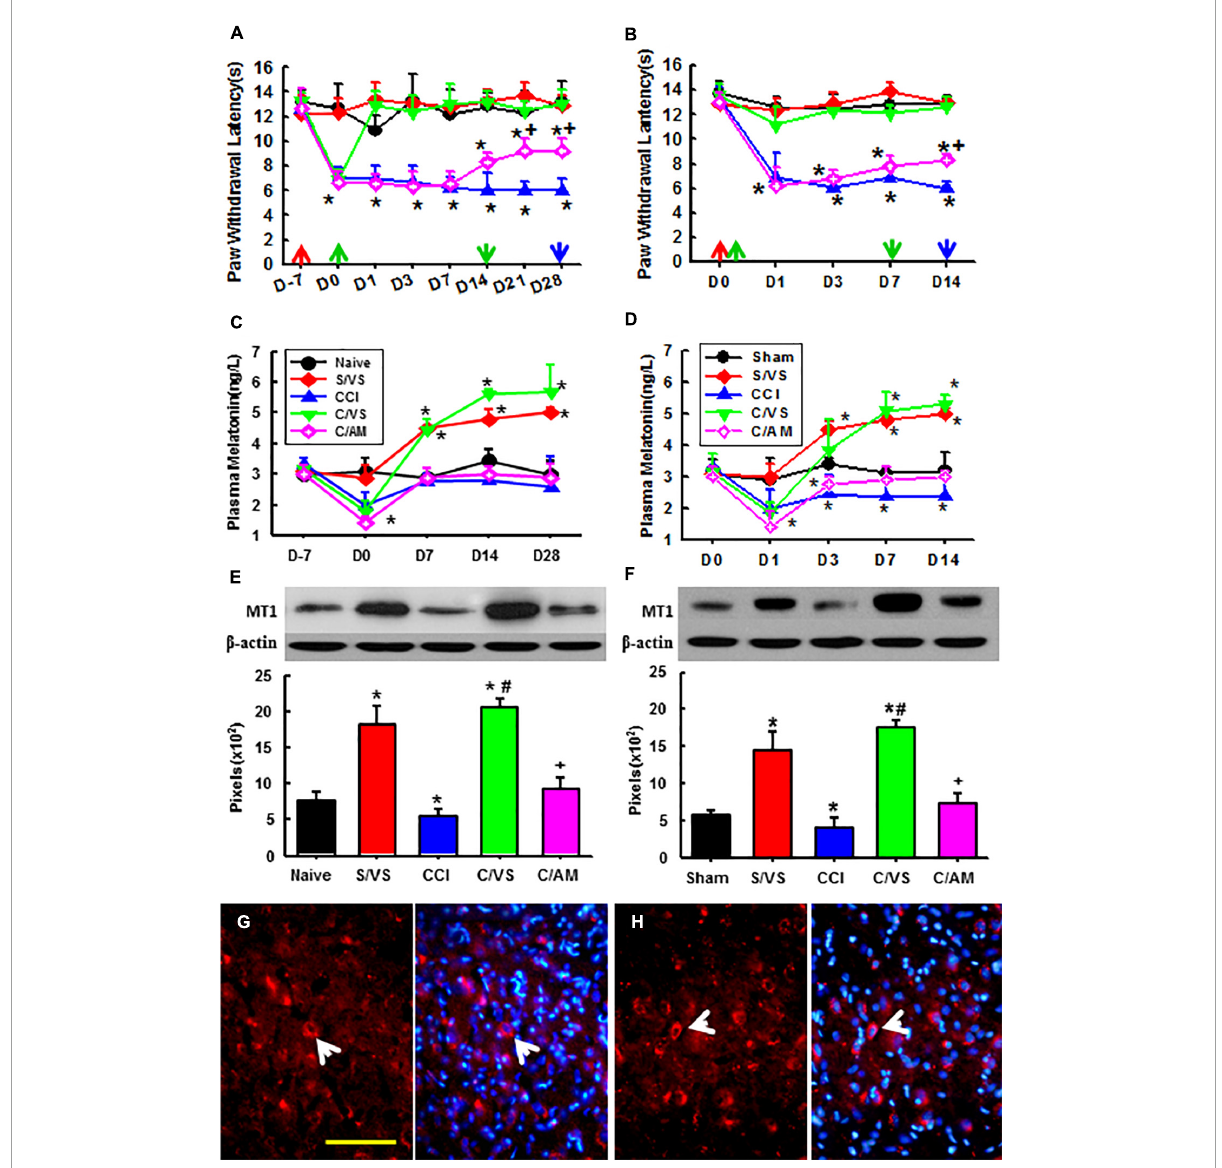
FIGURE2 Effects of taVNS on pain behavior, melatonin level, and MT1 expression. Showing the effect of taVNS on established (A) and developing (B) thermal hyperalgesia, corresponding plasma melatonin concentration (C,D) , and MT1 protein expression at the last time point (E,F) . D, day; red arrow, CCI or sham operation; the green up arrow, treatments start; the green down arrow, treatments end; the blue arrow, sacrifice; S/VS, CCI sham operation plus taVNS; CCI, sciatic nerve chronic constriction injury; C/VS, CCI + taVNS; C/AM, CCI + AMEA. * p < 0.05, as compared with naive or sham groups on the same day and the baseline of the same group; + p < 0.05 as compared with S/VS, CCI, and C/VS groups; and # p < 0.05 as compared with CCI and C/AM groups. (G) The MT1 positive neurons (the arrow) in the amygdala of ZDF rats, CCI treated with AMEA, on Day 28. (H) The MT1 positive neurons (the arrow) in the amygdala of the ZDF rats, CCI treated with taVNS, on Day 14. Bar, 100 µ